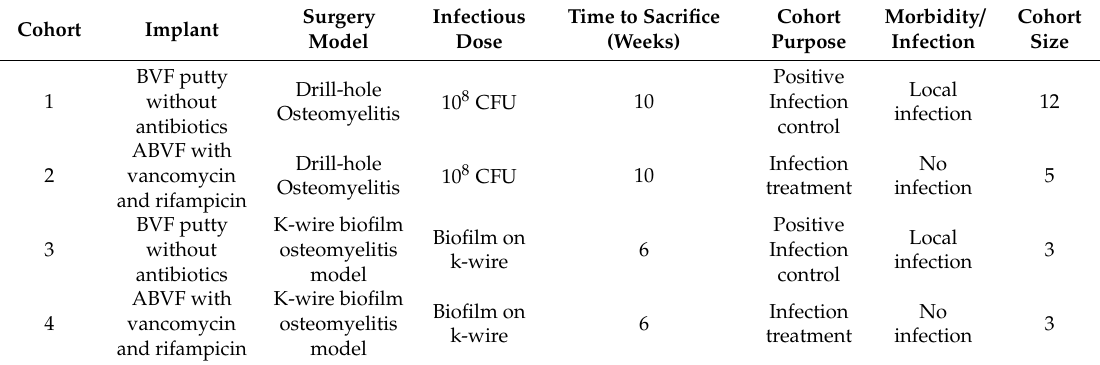
Table 1. Description of the cohorts used in this